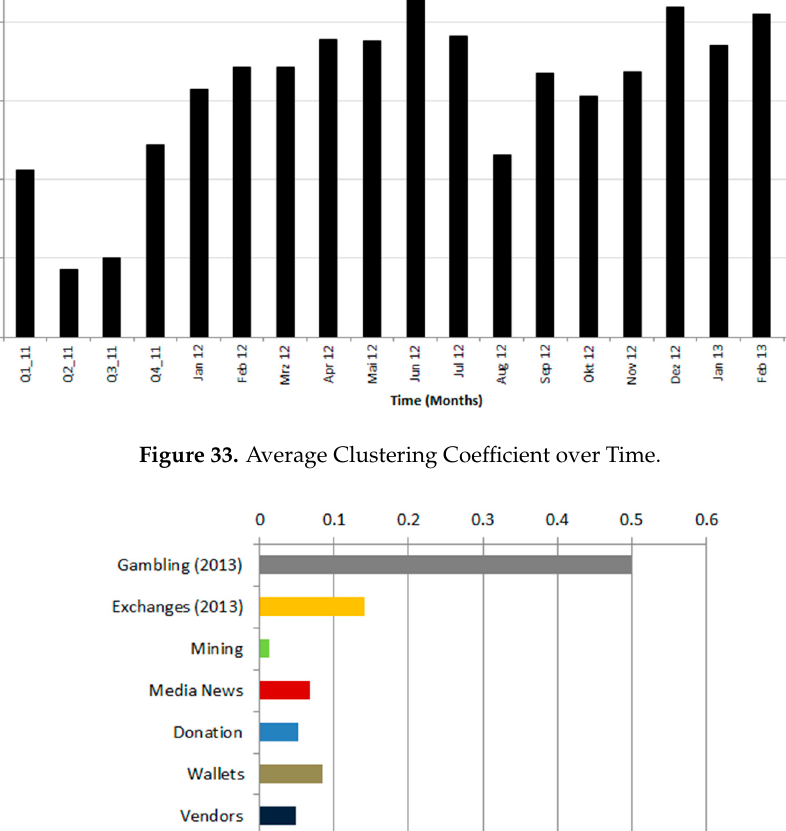
Figure 33. Average Clustering Coefficient over Time.